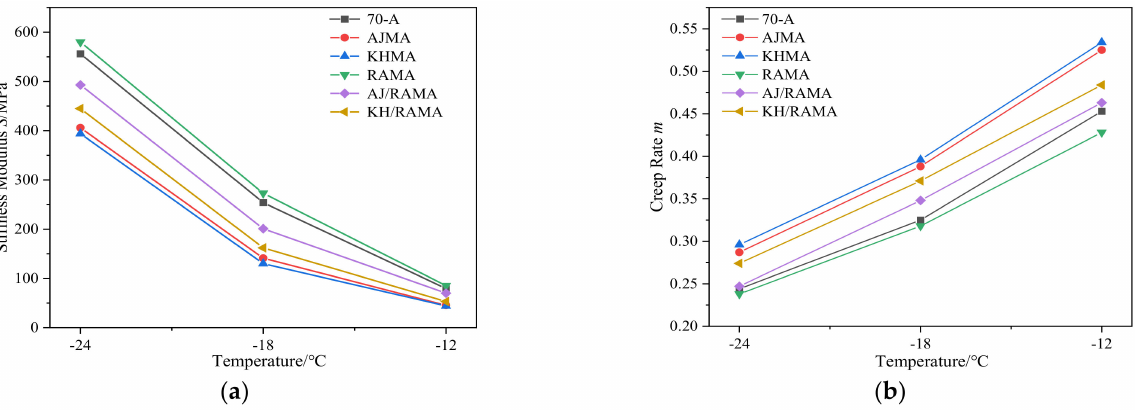
Figure 12. ( a ) Stiffness modulus S ; ( b ) Creep rate m